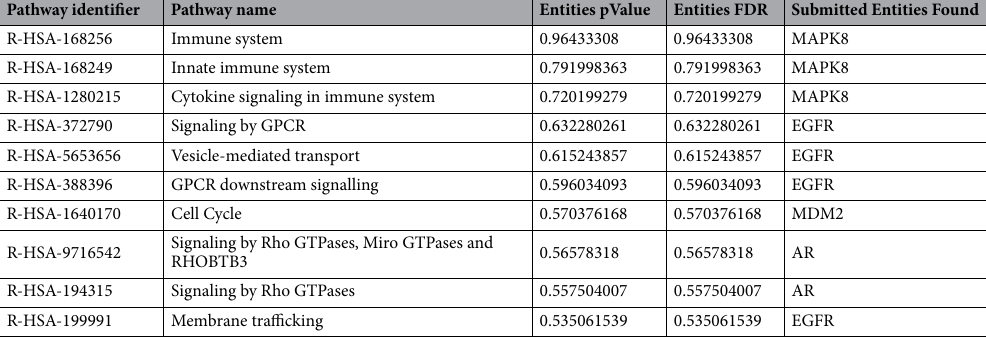
Table 4. Rectome analysis of core